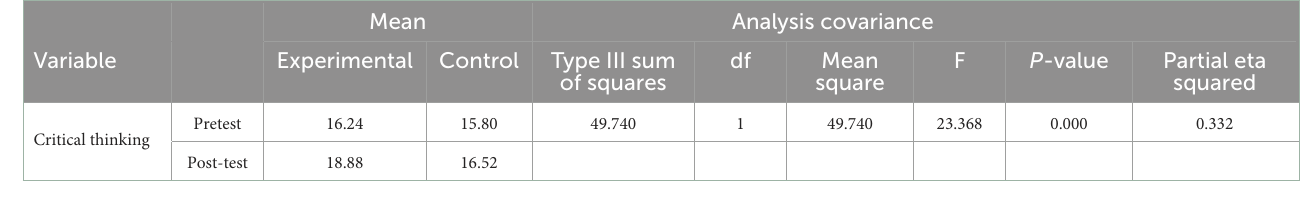
TABLE 5 Results of analysis of covariance for academic